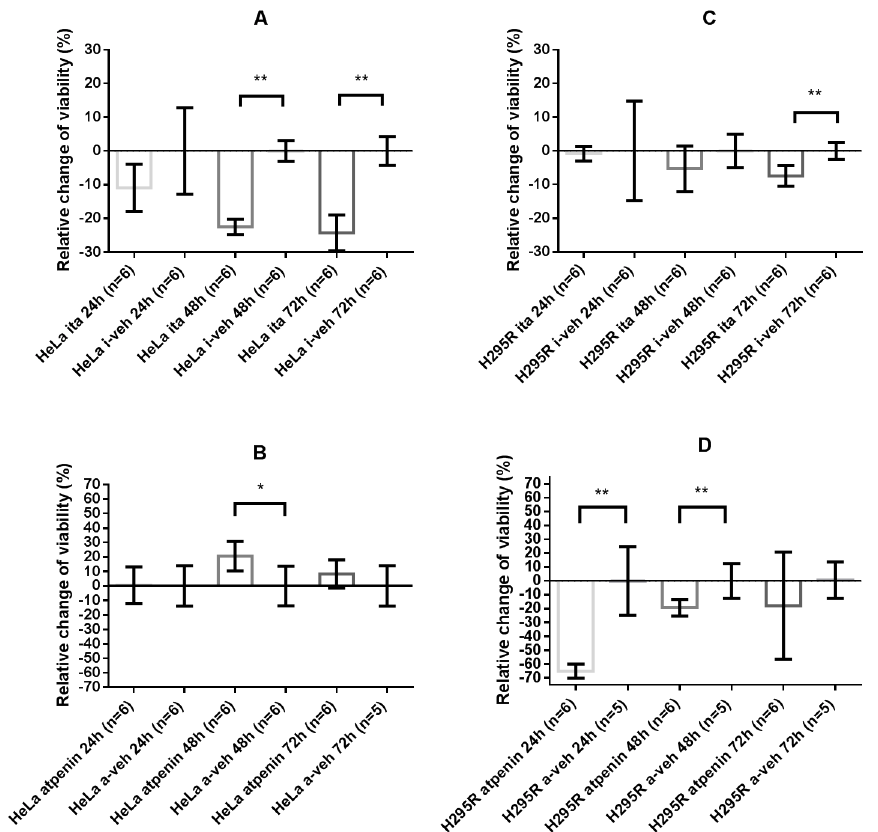
Figure 3. Cell viability measurements of HeLa and H295R cell lines. Values are normalized to the control values. A total of 100% was subtracted from the values, therefore, changes in % are presented compared to control. ( A ) Relative change of cell viability of HeLa cells after 24, 48, and 72 h itaconate treatment, compared to control. ( B ) Relative change of cell viability of HeLa cells after 24, 48, and 72 h atpenin treatment, compared to control. ( C ) Relative change of cell viability of H295R cells after 24, 48, and 72 h itaconate treatment, compared to control. ( D ) Relative change of cell viability of H295R cells after 24, 48, and 72 h atpenin treatment, compared to control. Veh: vehicle. *: p < 0.05; **: p < 0.01.